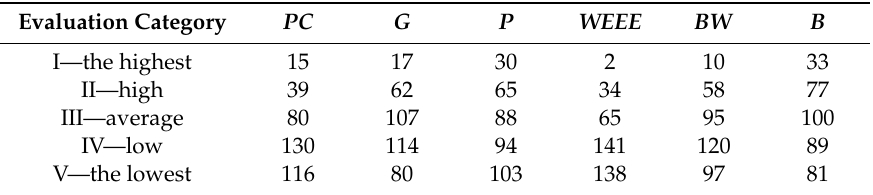
Table 3. The number of counties in particular ranges in waste management correctness categories for the chosen fractions of the selected